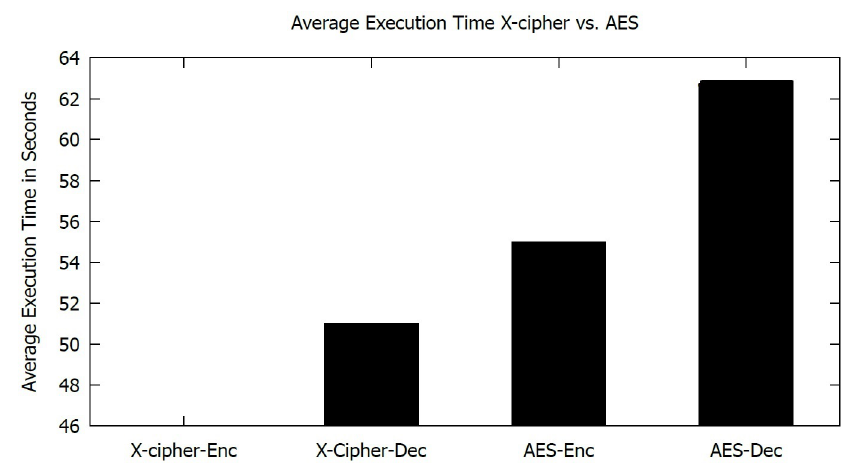
Figure 9. Average Memory usage for AES and X-cipher.